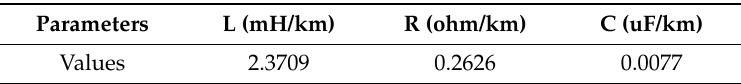
Table 2. Parameters of single grounding electrode line in case study.